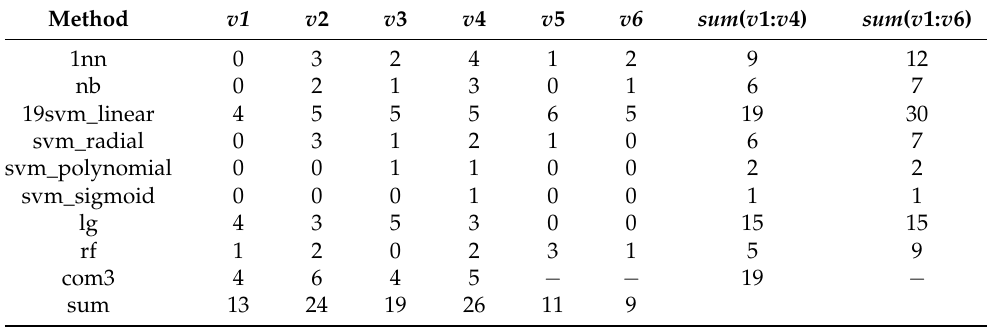
Table 12. Best results for THRESHOLD 0.6 : We counted the number of times the sensitivity thresh- old of 0.6 was exceeded. We considered variants v1 to v6. The best method was found to be svm_linear and com3 and variants v4 and v2. Slightly better were v4 and svm_linear. It is worth noting that com3 also includes svm_linear. In yellow, we highlighted the best methods and